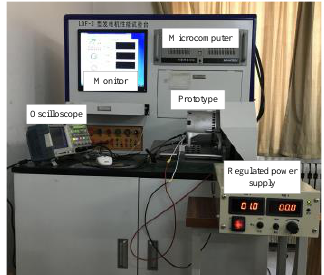
Figure 15. Generator test bench.